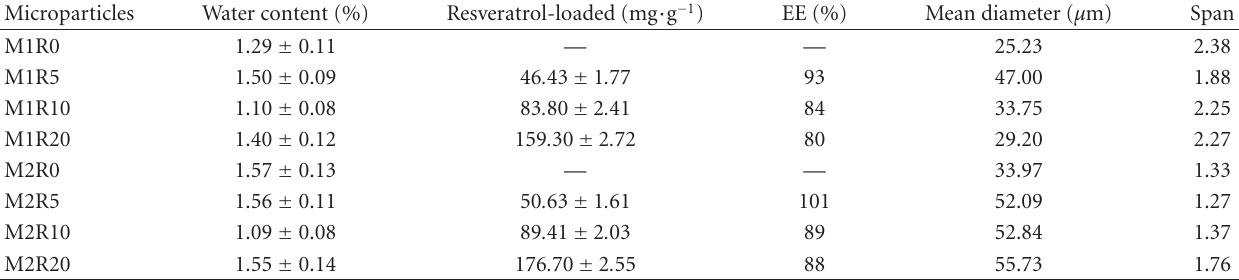
Table 3: Water content 1 , resveratrol entrapped into microparticles 1 , encapsulation e ffi ciency (EE) 2 , particle size, and span for PHBV/PCL